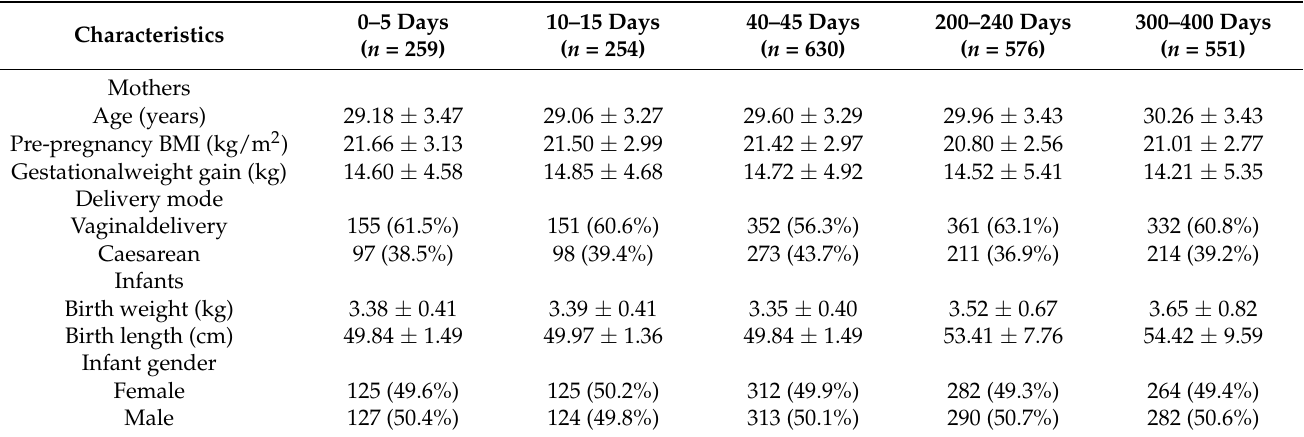
Table 1. Demographic and anthropometric characteristics of lactating women and corresponding